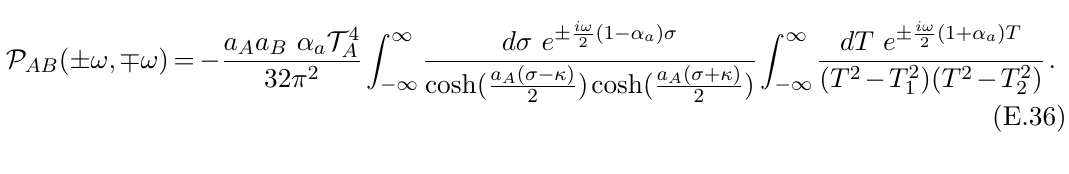
Figure 13. Plots showing contours of integral (a) P AB ( ω, − ω ) , (b) P AB ( − ω, ω ) , where contributing poles are in upper and lower half of the complex- σ plane, respectively. The poles ¯ M defined as κ + iπ (2 n +1) and − κ + iπ (2 n +1) , a A a A